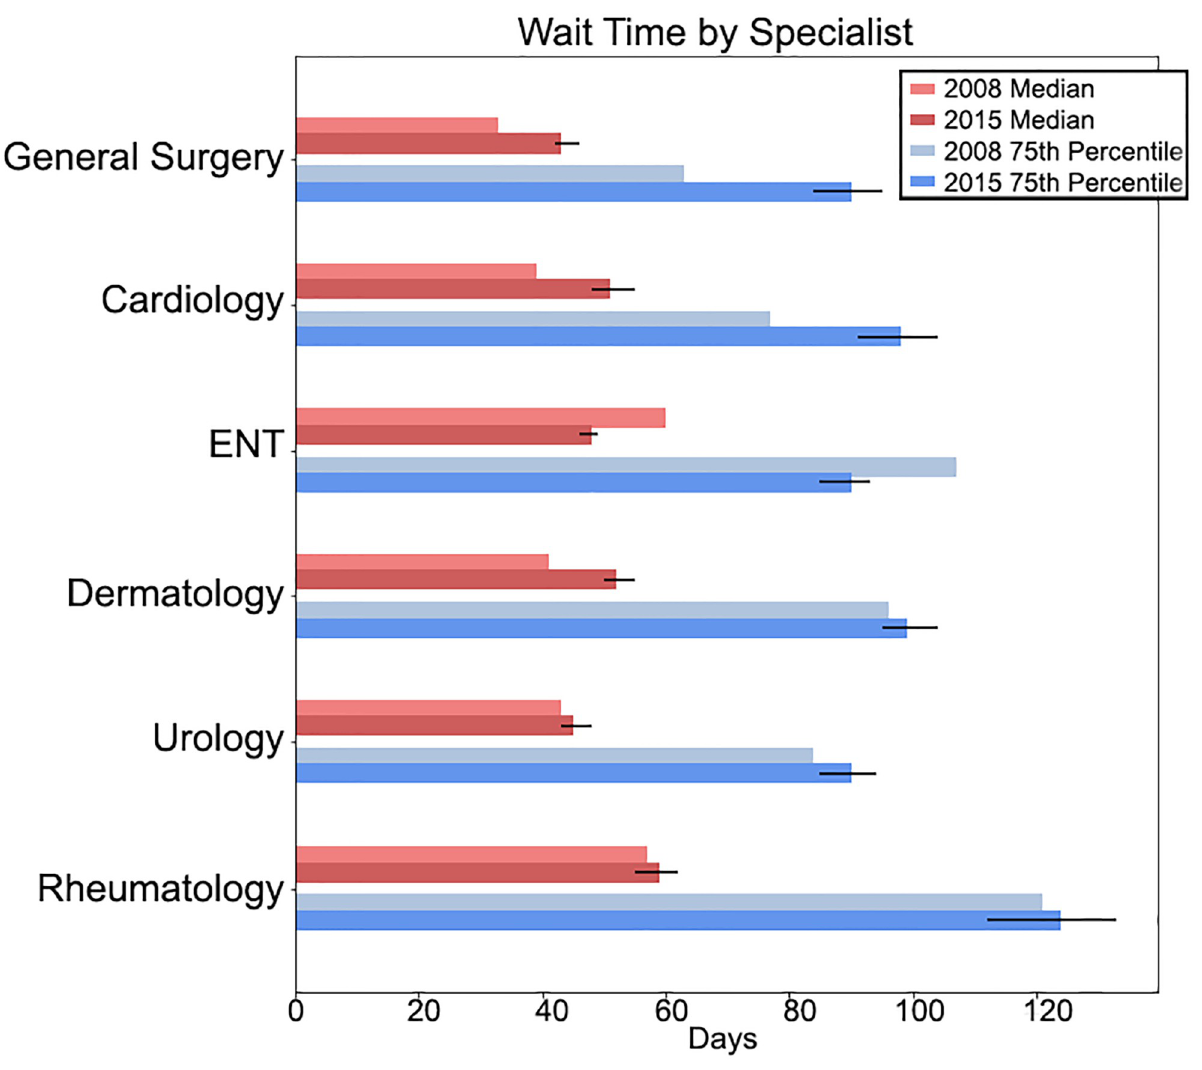
Fig 5. The estimated median and 75 th percentile wait time from family physician referral to specialist visit for four specialties. The error bars represent 95% confidence interval (arrived at by bootstrapping). The 2008 numbers are from our previous work and relied on manual